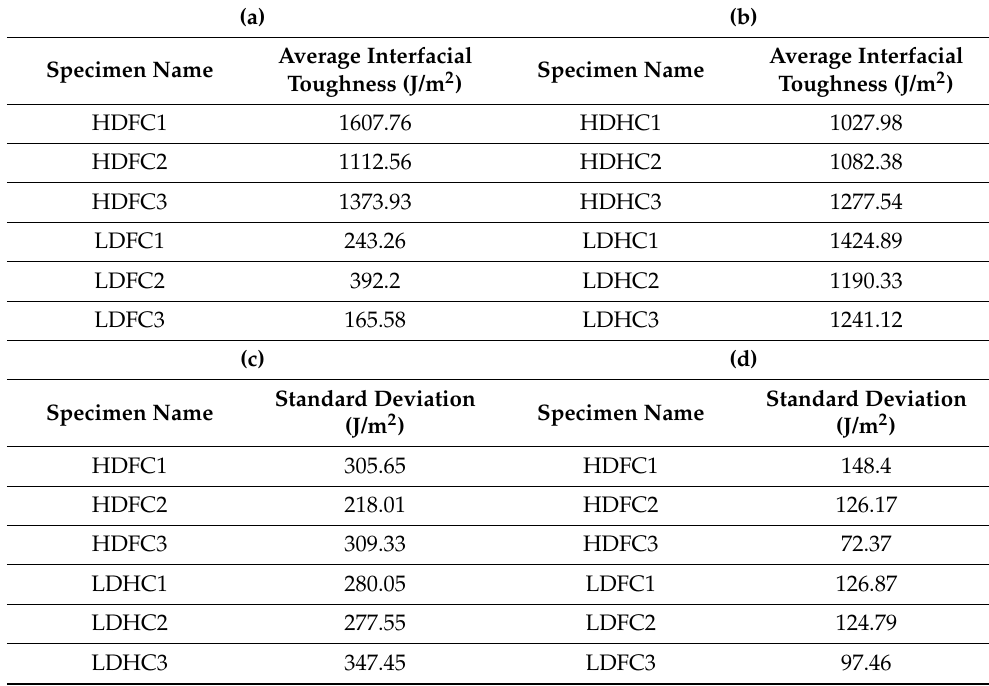
Figure 14. Comparison of debond resistance curve (G IC vs. a) for all 4 SCB sandwich structures.